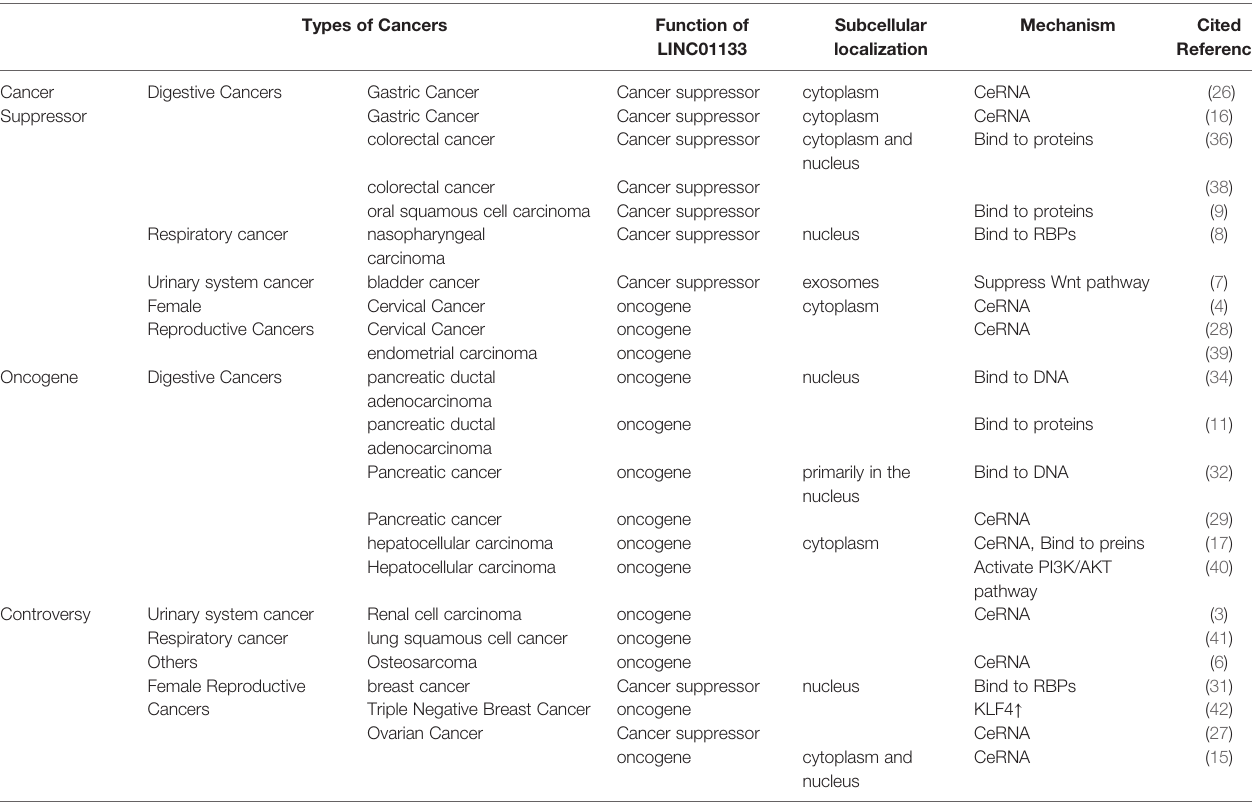
TABLE 2 | Characterization of LINC01133 in